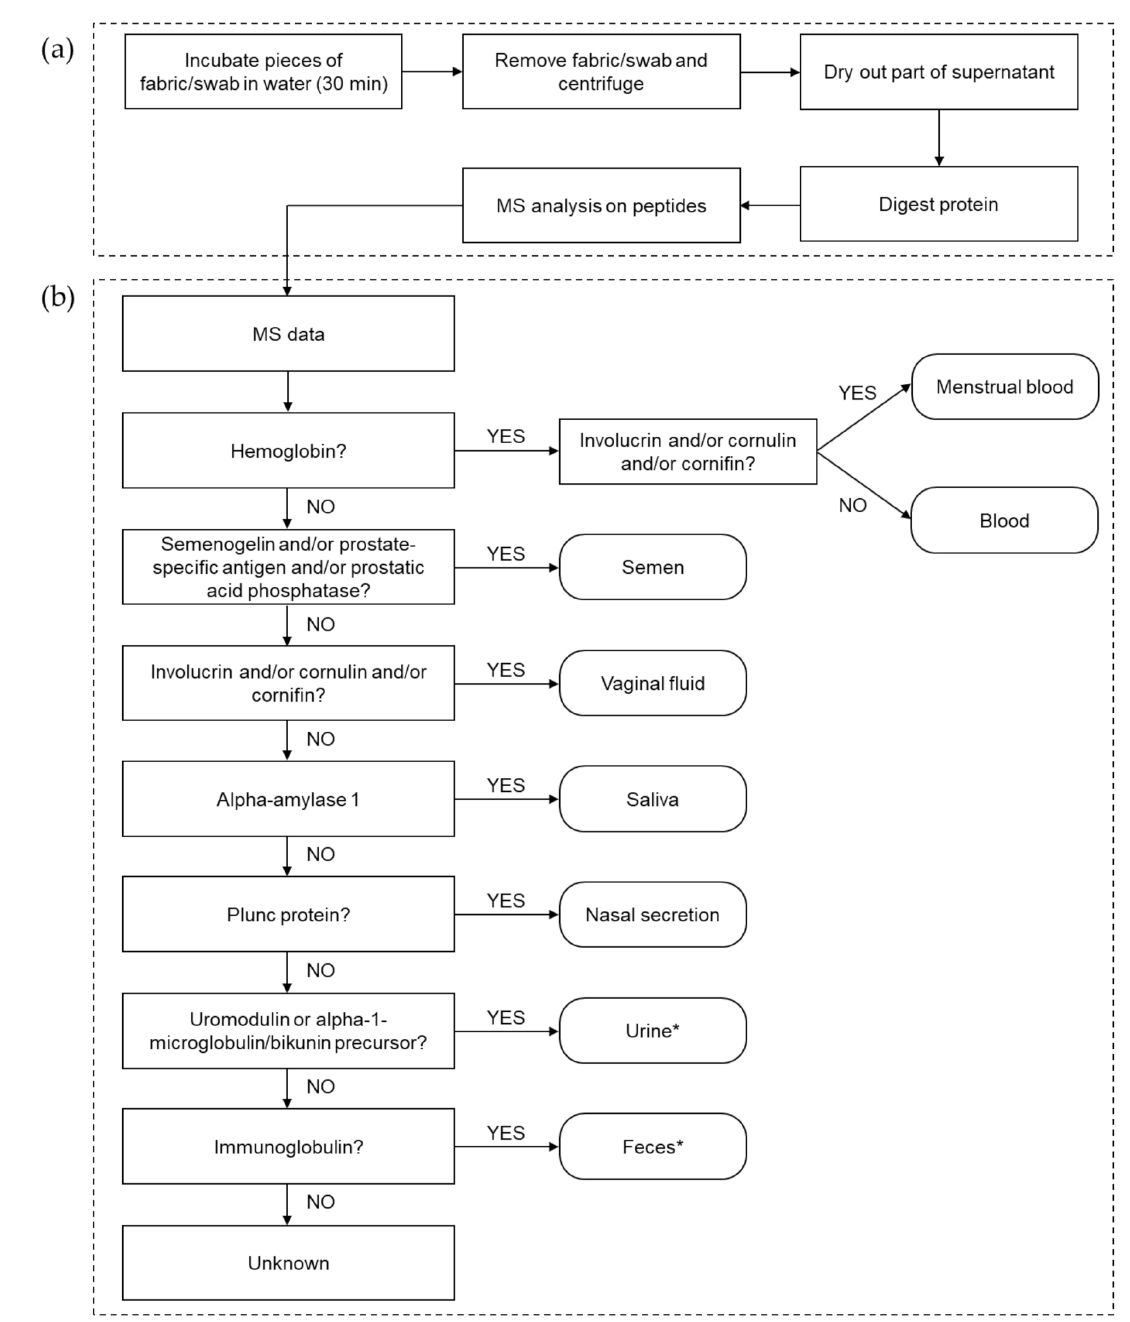
Figure 4. Identification of biological matrices in forensic proteomics. ( a ) Workflow for mass spectrometry-based identi- fication of biological matrices. ( b ) Decision tree with biomarkers per biological matrix. * The absence of the biomarker (uromodulin/alpha-1-microglobulin/bikunin precursor protein or immunoglobulins) does not necessarily exclude the presence of the matrix (urine or feces, respectively). Figures redrawn from [14], under the terms of the Creative Commons Attribution 2.0 International License (CC BY 2.0) https://creativecommons.org/licenses/by/2.0 (accessed on 3 March